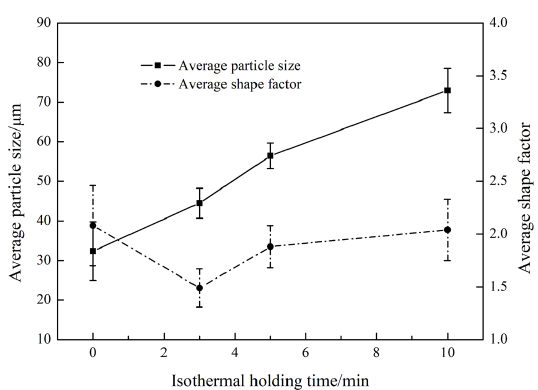
Figure 7. Changes of primary particle size and shape factor with holding time.